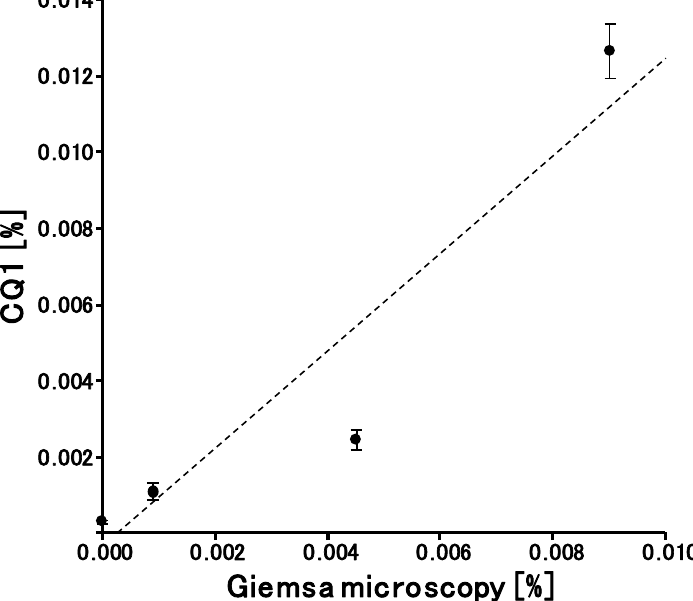
Figure 5. Comparative analysis of the parasitemia estimated with CQ1 and Giemsa microscopy. Linear regression analysis was used. Data are expressed as the mean ± SD for five different experiments.